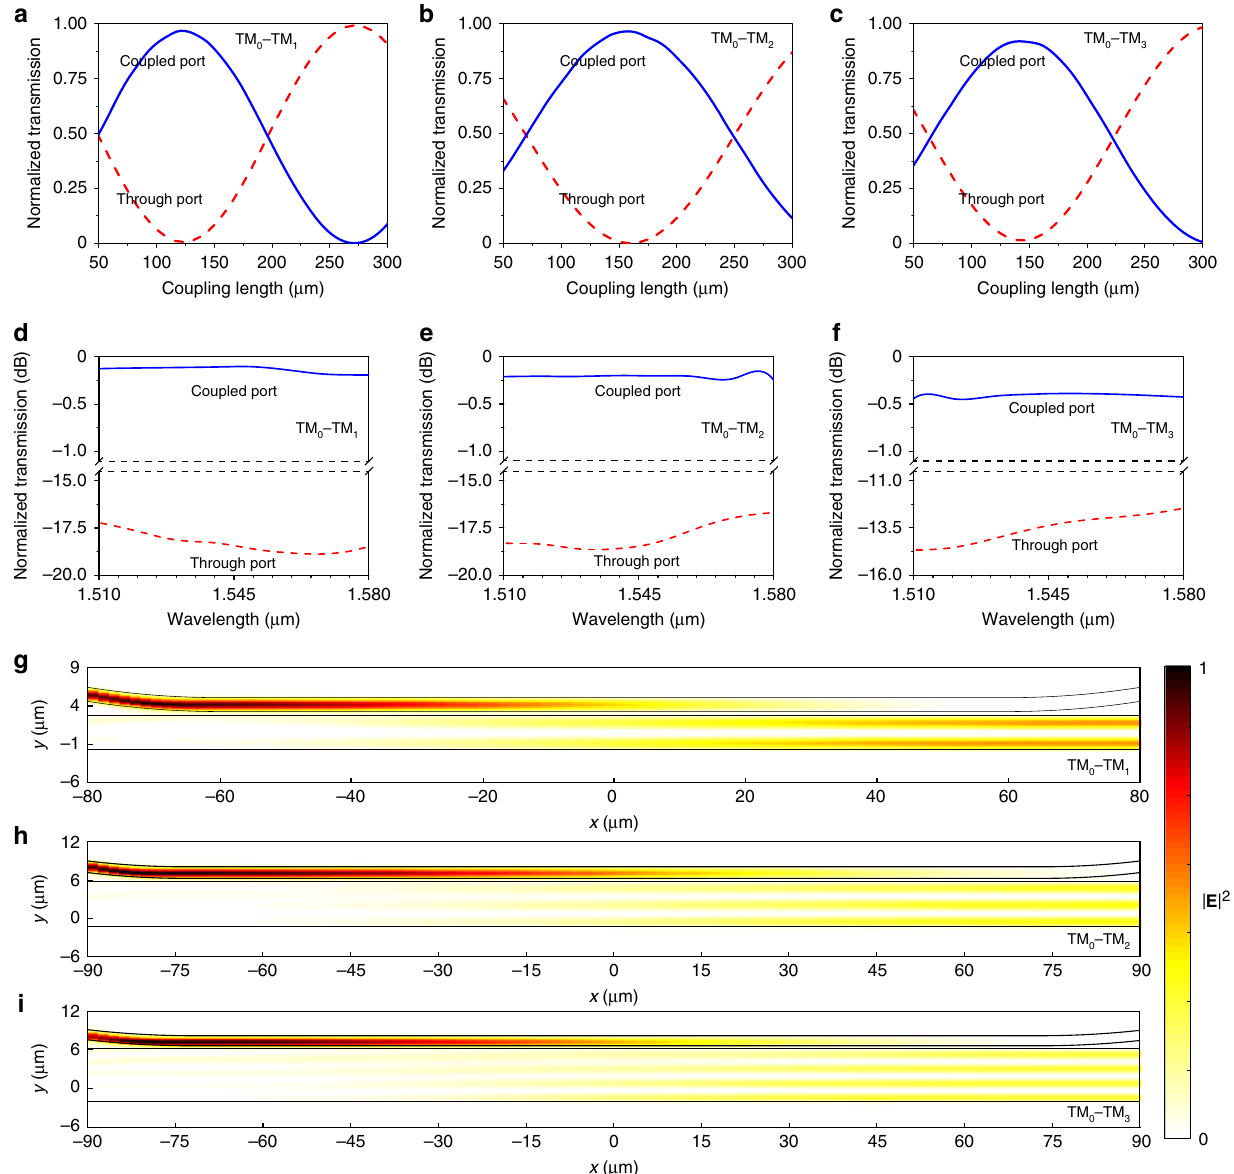
Fig. 3 Simulated properties of BIC multimode directional couplers. a – c Normalized transmission of the coupled and through ports at the wavelength of 1.55 µ m for the TM 0 – TM 1 ( a ), TM 0 – TM 2 ( b ), and TM 0 – TM 3 ( c ) multimode directional couplers as a function of the coupling length. The TM 0 mode can be converted entirely into the TM 1 , TM 2 , and TM 3 modes through the respective directional couplers. d – f Normalized transmission spectra of the coupled and through ports of the TM 0 ‒ TM 1 ( d ), TM 0 ‒ TM 2 ( e ), and TM 0 ‒ TM 3 ( f ) multimode directional couplers with the respective coupling length of 125, 157, and 143 µ m. The designed TM 0 ‒ TM 1 , TM 0 ‒ TM 2 , and TM 0 ‒ TM 3 multimode directional couplers can achieve coupling loss <0.20, 0.25, and 0.45 dB, respectively, with extinction ratio >17.5, 16.5, and 12.0 dB, respectively, in the wavelength range of 1.51 ‒ 1.58 µ m. g – i Electric fi eld | E | 2 pro fi les of light coupled from the TM 0 mode to the TM 1 ( g ), TM 2 ( h ), and TM 3 ( i ) modes through the respective multimode directional − 15.7, and − 18.5 dB, respectively, at the wavelength of 1.55 μ m High-dimensional communication . We constructed a four- channel TM mode (de)multiplexer by cascading the above and < − 9.5 dB in the wavelength range of 1.51 – 1.58 μ m. demonstrated multimode directional couplers. Figure 5a shows To demonstrate the capability of on-chip electro-optic an optical microscope image of the fabricated device. Figure 5b – e modulation and mode (de)multiplexing, we integrated electro- show the measured normalized spectra of light transmission from optic modulators with the mode (de)multiplexer on the same chip each of the four input ports to each of the four output ports. The as shown in Fig. 6a. Light sent into the four input channels was fi rst modulated by a microcavity electro-optic modulator in each insertion loss is 0.8 (<1.7), 2.8 (<3.4), 2.7 (<4.0), and 2.7 (<3.3) dB for the TM 0 , TM 1 , TM 2 , and TM 3 modes, respectively, measured channel, then passed through the mode (de)multiplexer before at the wavelength of 1.55 μ m (in the wavelength range of being directed to the corresponding output channels. Figure 6b 1.51 – 1.58 μ m). The crosstalk from other mode channels to the shows the experimental setup, where the light from a semi- TM 0 , TM 1 , TM 2 , and TM 3 mode channels is − 14.1, − 13.8, conductor laser at the wavelength of ~1.55 μ m was ampli fi ed by